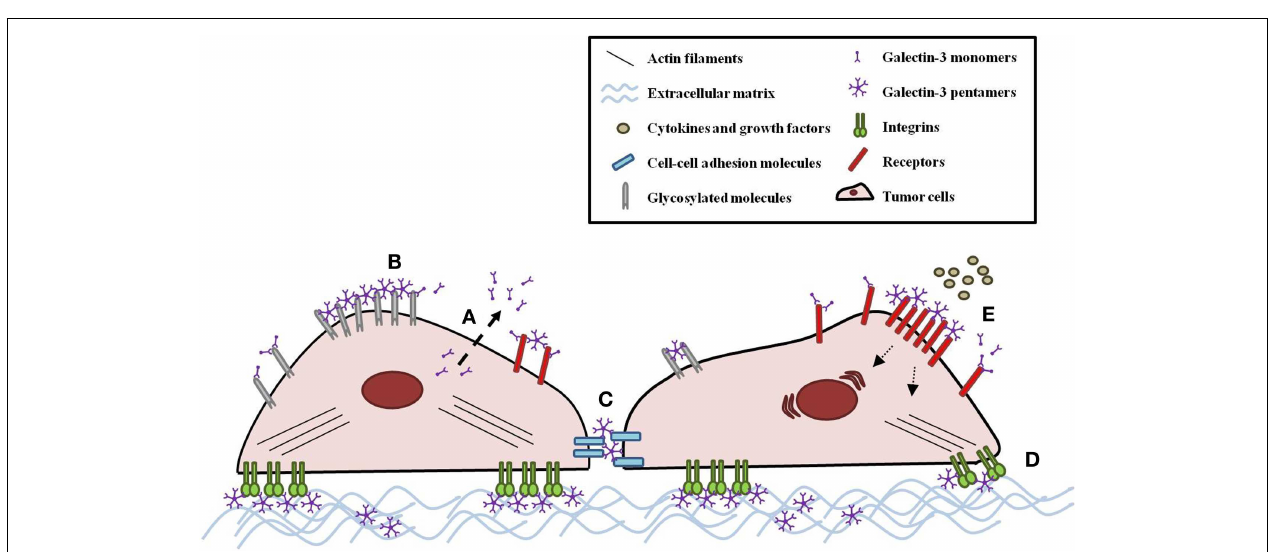
through their N-terminal domain, establishing pentameric structures. (B) This complex cross-links carbohydrate-containing glycans, promoting the formation of organized galectin–glycan clusters termed lattices and modulating tumor cell behavior, such as (C) adhesion and (D) migration. (E) Galectin-3-glycan lattices also extend the exposition of receptors on the cell surface, affecting cell response to cytokines and growth